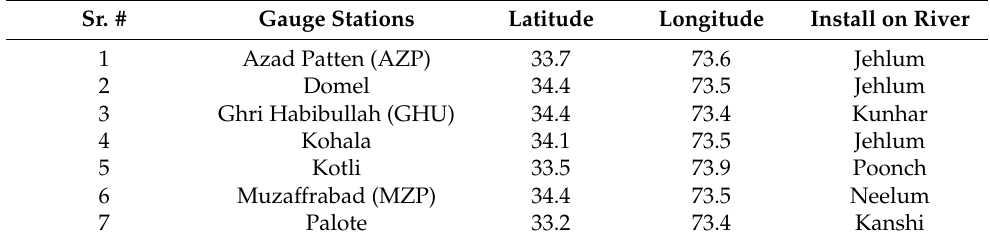
Table 1. Gauges’ location in Mangla Watershed. Sr.